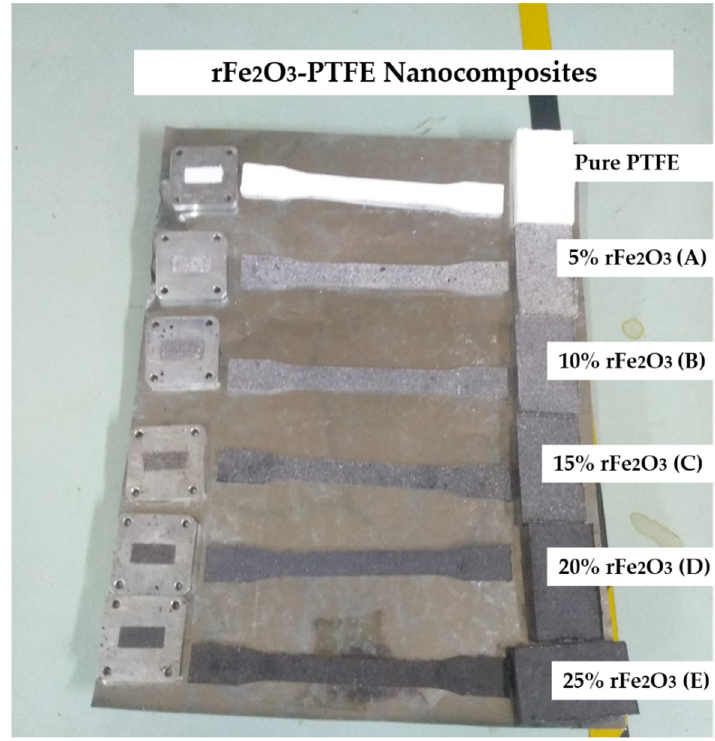
Figure 1. Preparation process of rFe 2 O 3 nanoparticles.